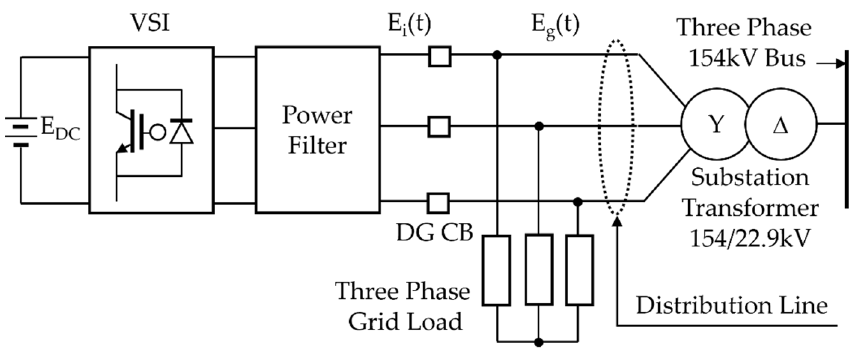
Figure 1. Configuration of SG connected with DG.